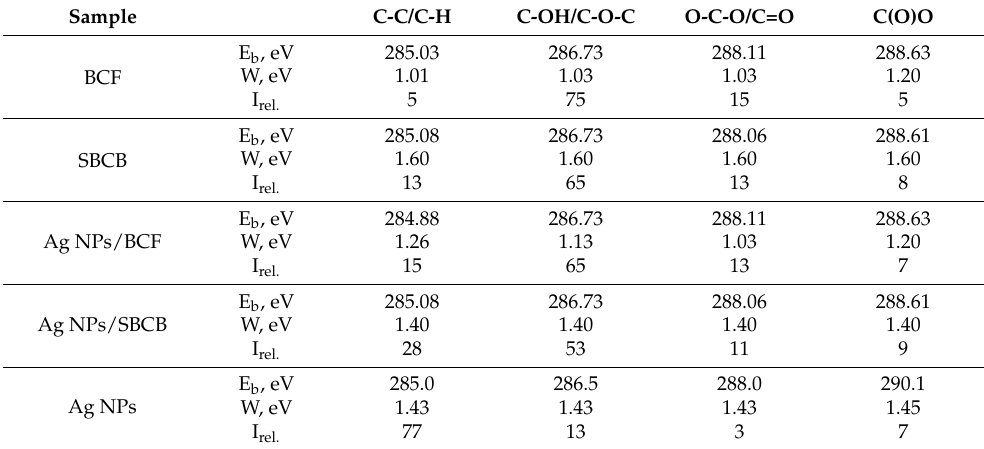
Table 3. Characteristics of the C 1s photoelectron spectra: binding energies (E b ), Gaussian widths (W), and relative intensities (I rel ) of photoelectron peaks belonging to different chemical groups.